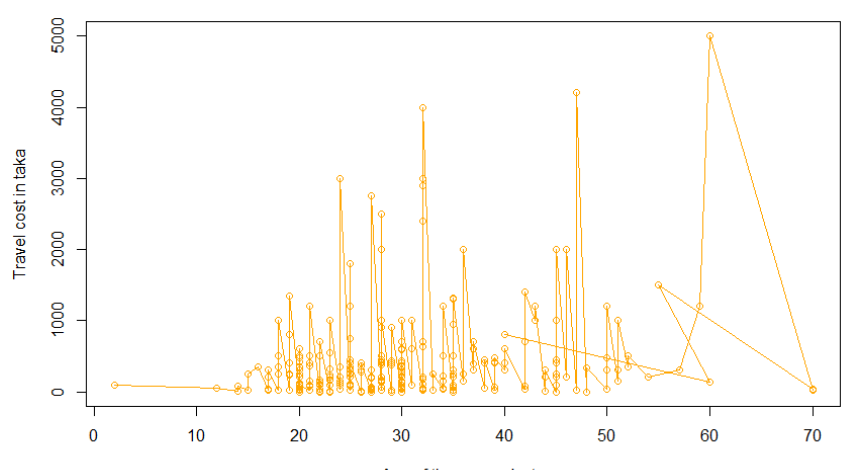
Fig. 2. Relationship between age and travel